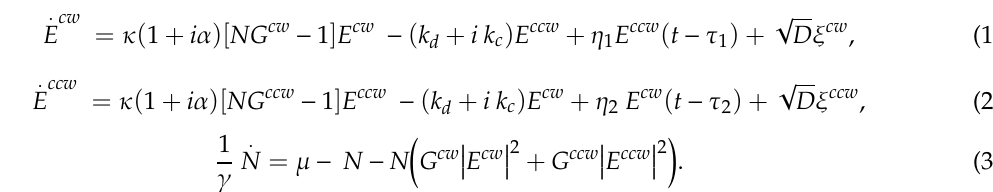
Figure 2. Schematic of the experimental setup. LF, lensed fiber; SOA2, semiconductor optical amplifier used to tune the coherent optical feedback (COF) strength; TF, tunable optical bandpass filter; Det, fast opto-electronic detector; PC, polarization controller.